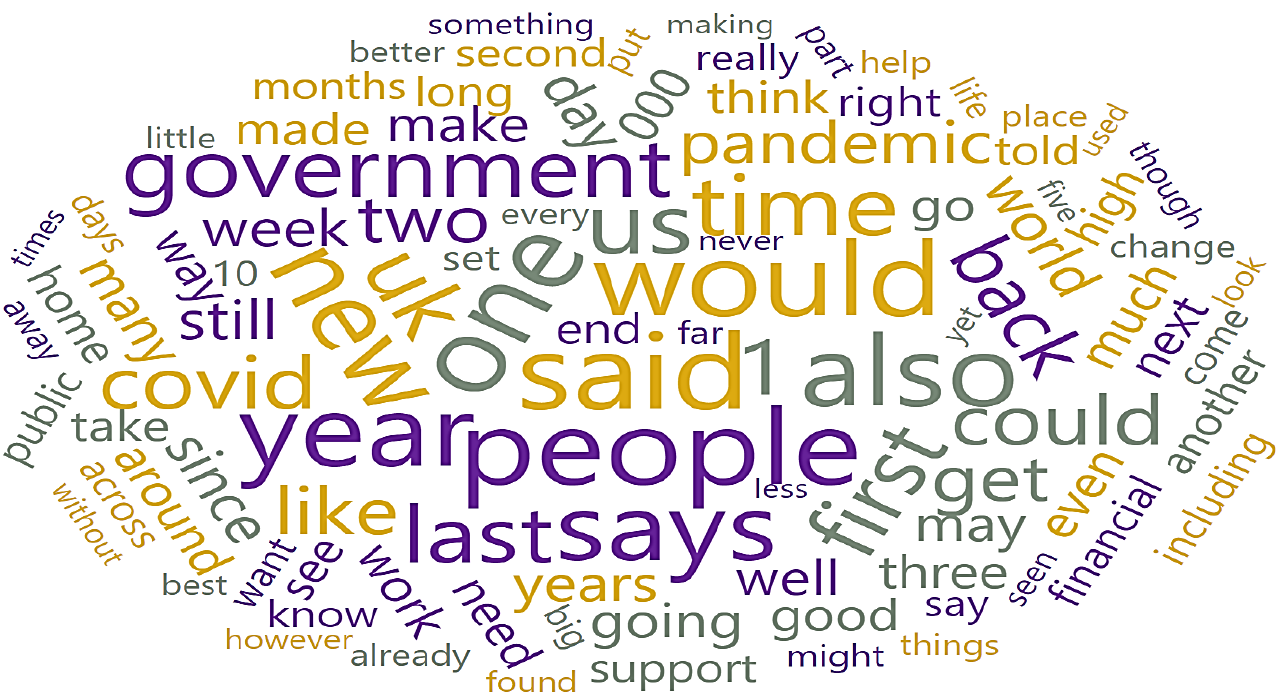
Figure 5. Visualization of Guardian Dataset Through Heat Map.